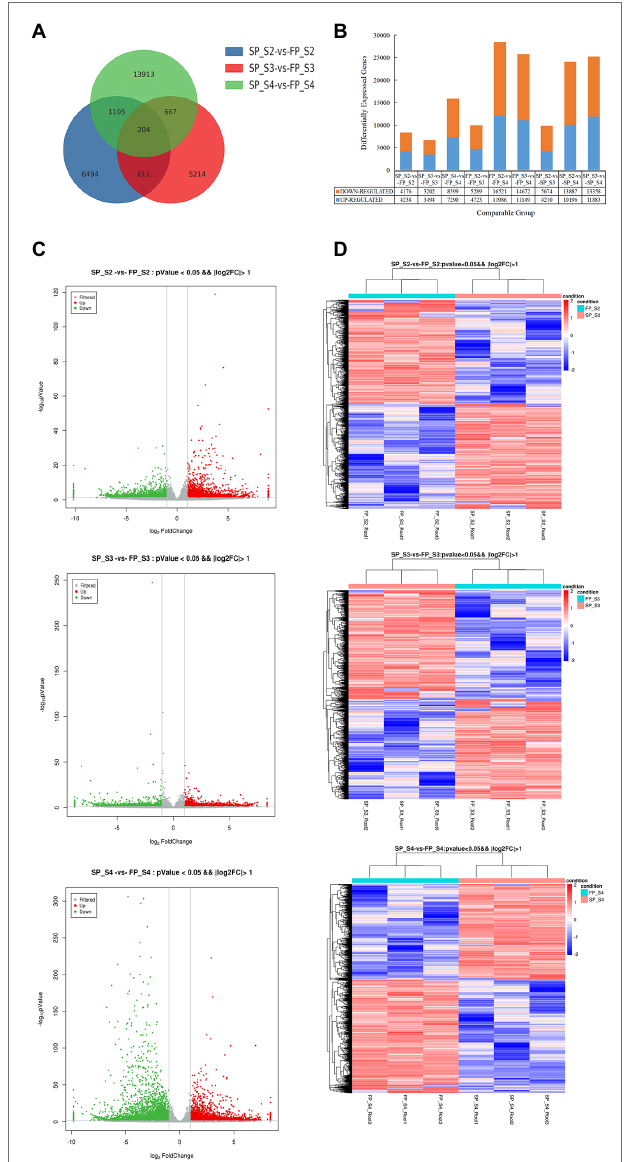
FIGURE 2 | Expression profile of differentially expressed genes (DEGs) at three periods of patchouli roots under continuous cropping stress. (A) Numbers of DEGs. (B) Venn diagram of the number of DEGs at each periods under continuous cropping stress. (C) Volcano plot. Each point in the volcano plot represents a gene, the green points represent downregulated genes, the red points represent upregulated genes, and the gray points represent unchanged genes. (D) Hierarchical clustering analysis of all DEGs. Different columns in the figure represent different samples, and different rows represent different genes. Colors from blue to red indicate gene expression from low to high,